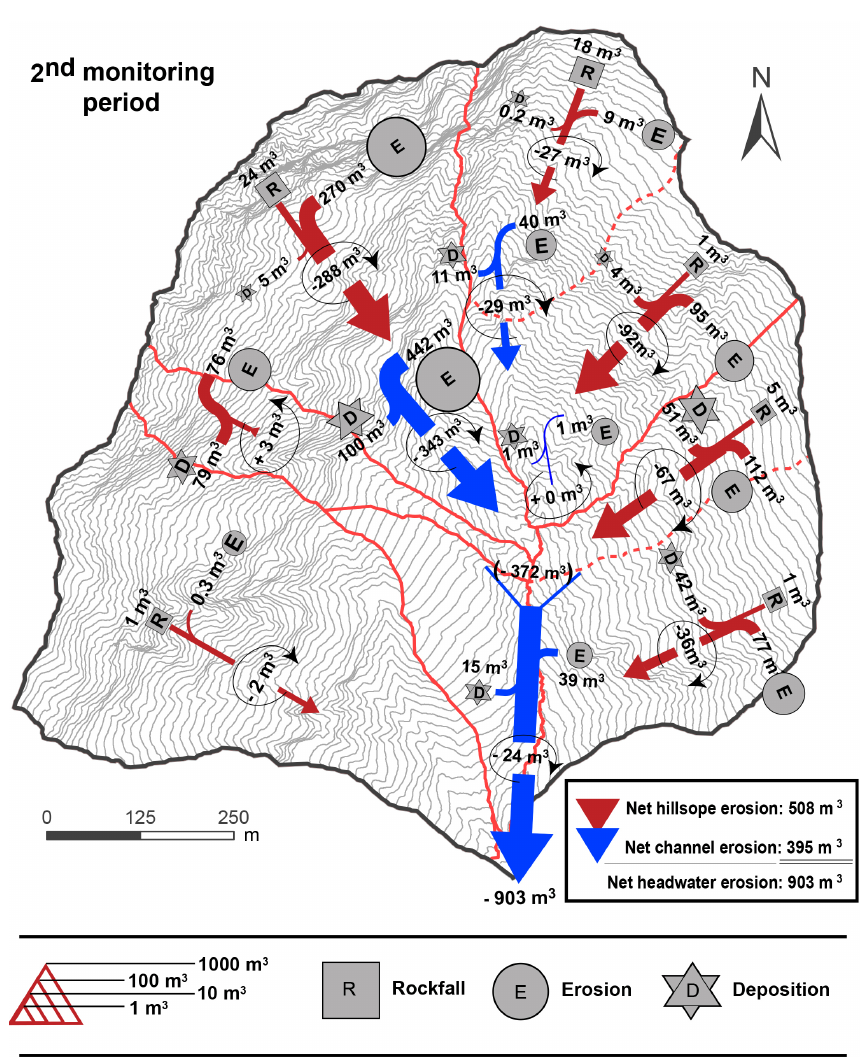
Figure 14. Overall headwater sediment budget observed during the second monitoring period revealing the sediment dynamics and the net balance of sediment recharge in the downstream torrent during the